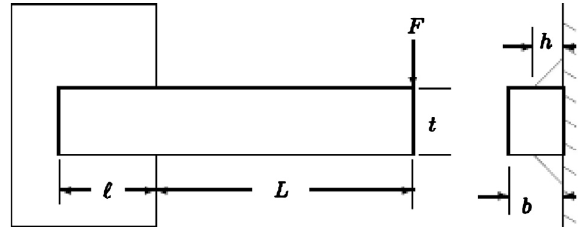
Figure 5. Welded beam design (Example 1).